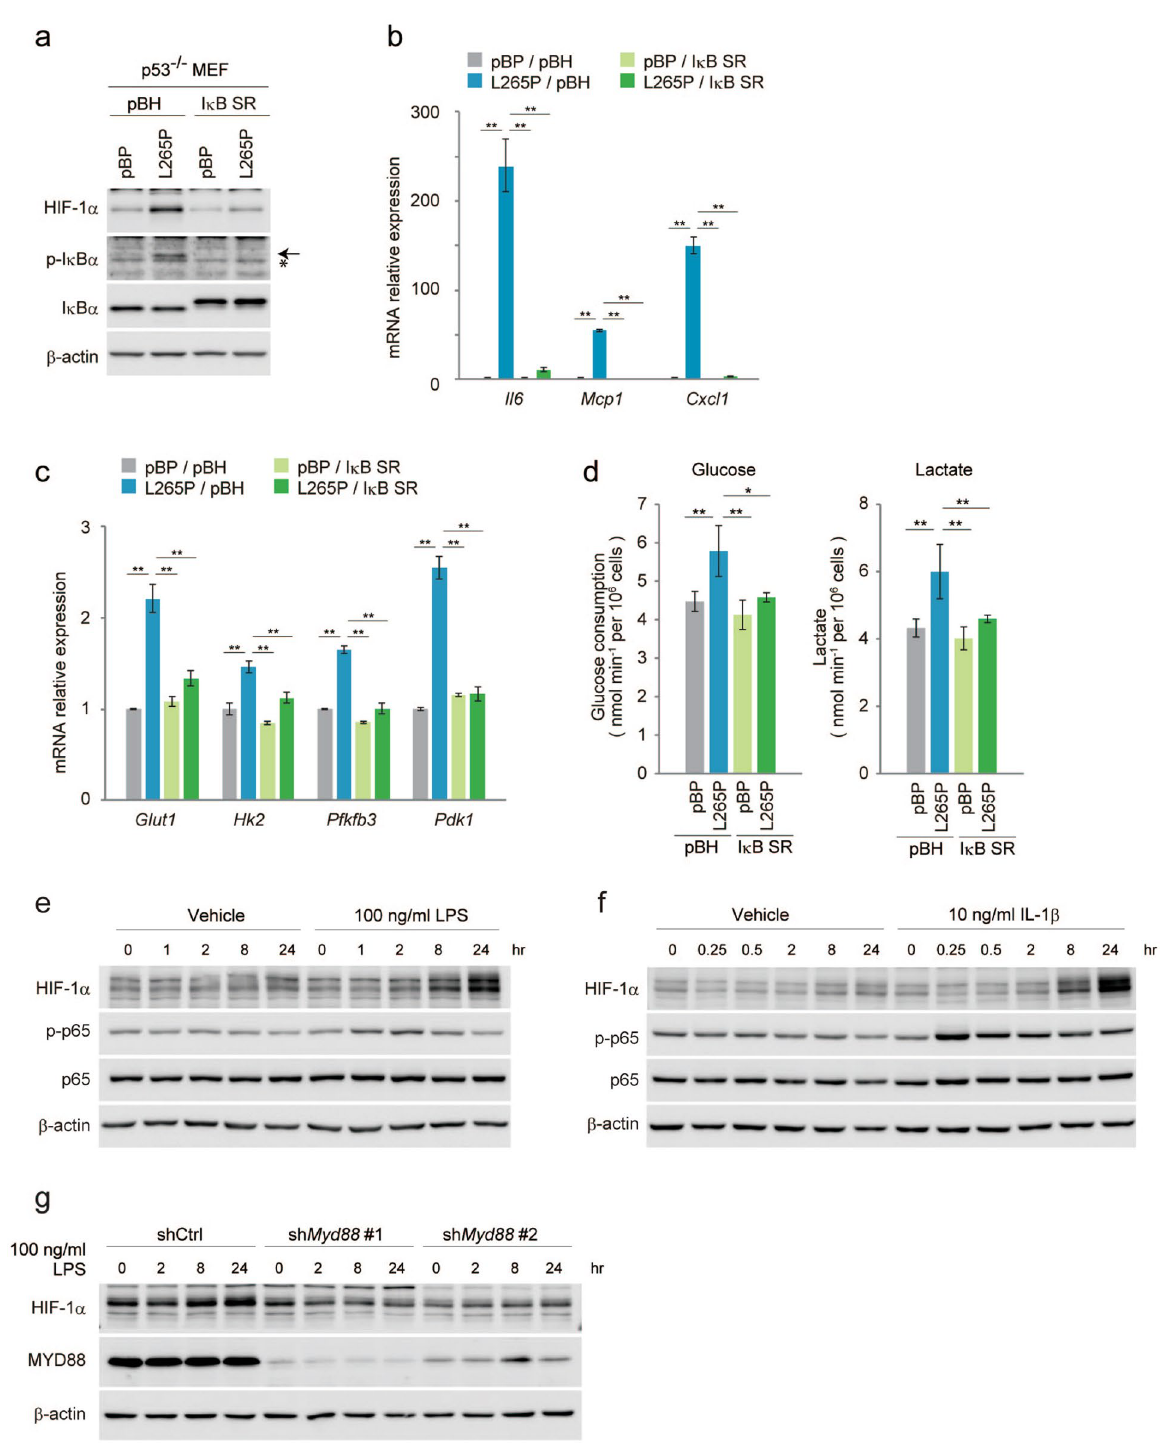
Figure 2. Suppression of NF-κB reduces HIF-1α expression and glucose metabolism in MYD88 L265P- expressing p53 −/− MEFs. ( a – d ) Suppression of NF-κB using IκB SR in p53 −/− MEFs expressing MYD88 L265P. ( a ) Total cell lysates were analysed by immunoblotting. The arrow indicates phosphorylated-IκBα and the asterisk indicates a nonspecific band. ( b ) Gene expression of NF-κB targets measured by qPCR. ( c ) Expression of glucose metabolism-related genes were quantified by qPCR. ( d ) Glucose uptake and lactate production were measured. The quantified results are presented as the mean ± s.d. (n = 4) using one-way ANOVA followed by Scheffe’s F test. *P < 0.05, **P < 0.01. ( e , f ) p53 −/− MEFs were treated with LPS and IL-1β for the indicated times. ( g ) Endogenous MYD88 expression were reduced by shRNA (#1 and #2), then these cells were stimulated with LPS for the indicated times. ( b , c ) The y-axis values are relative fold change for gene transcripts normalised to β-actin. Data represent the mean ± s.d. (n = 3) using one-way ANOVA followed by Scheffe’s F test. *P < 0.05, **P <